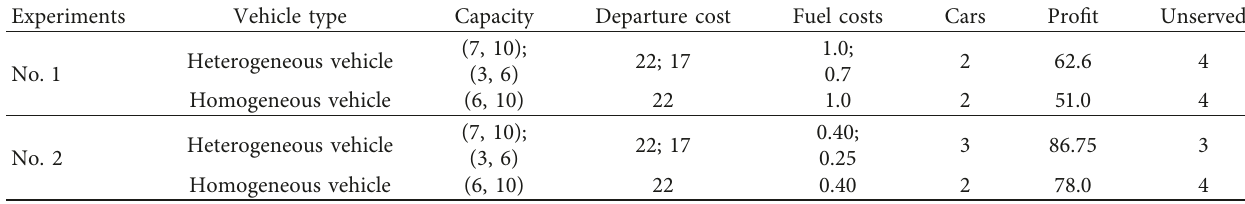
Table 7: Impact of various parameters.